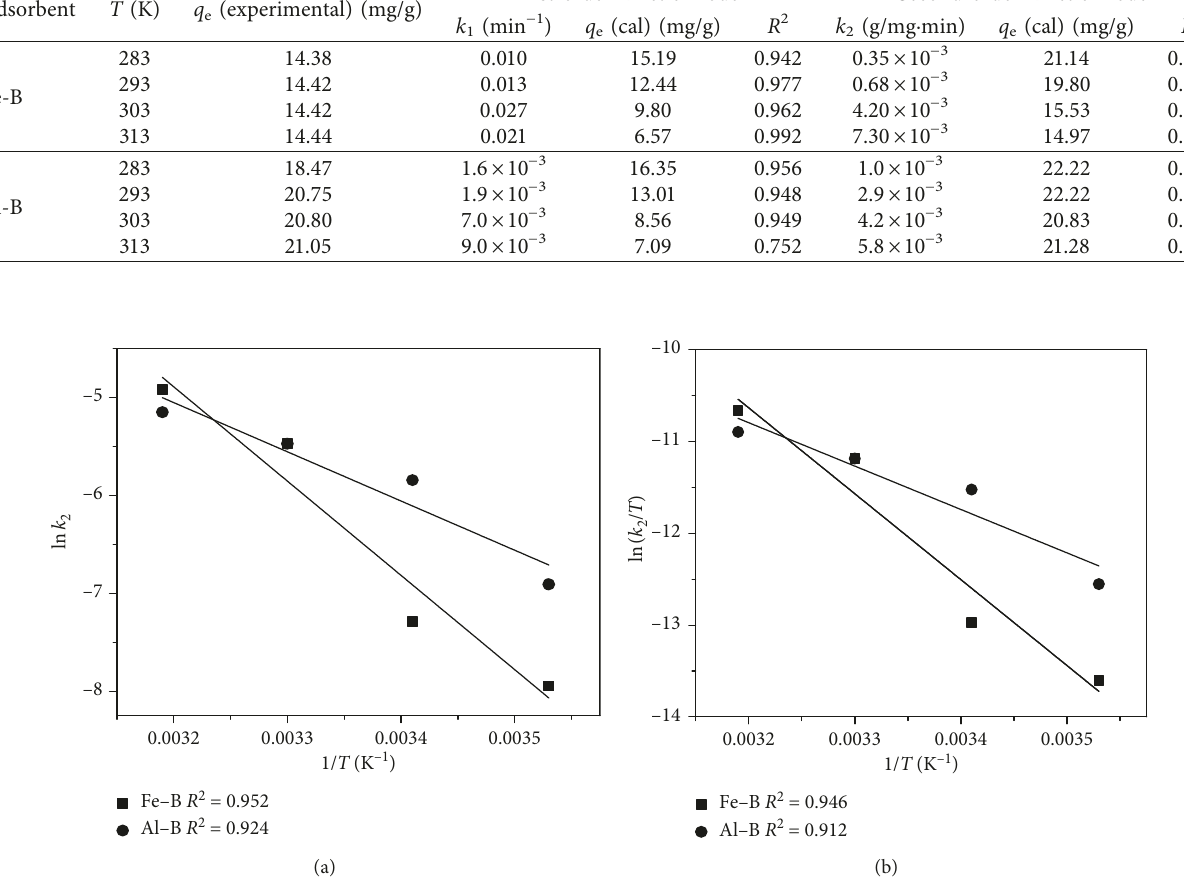
Figure 11: (a) Arrhenius plots and (b) Eyring plots of As(V) adsorption onto Fe-B and